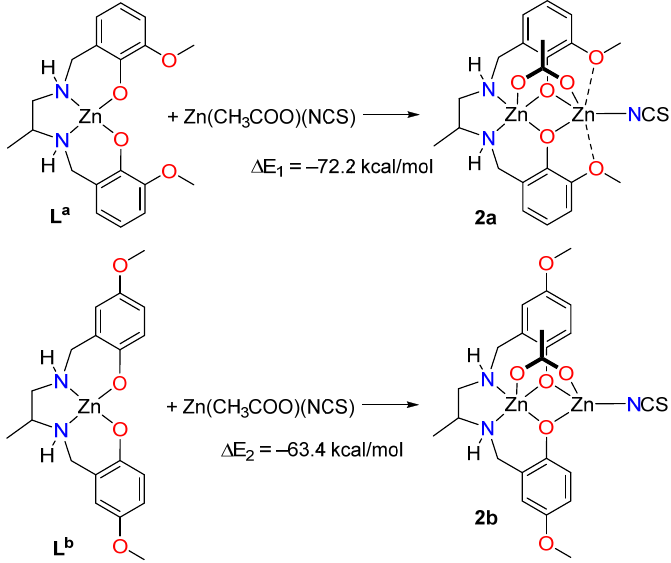
Figure 6. Reactions used to evaluate the SpB energy in compound 2 .